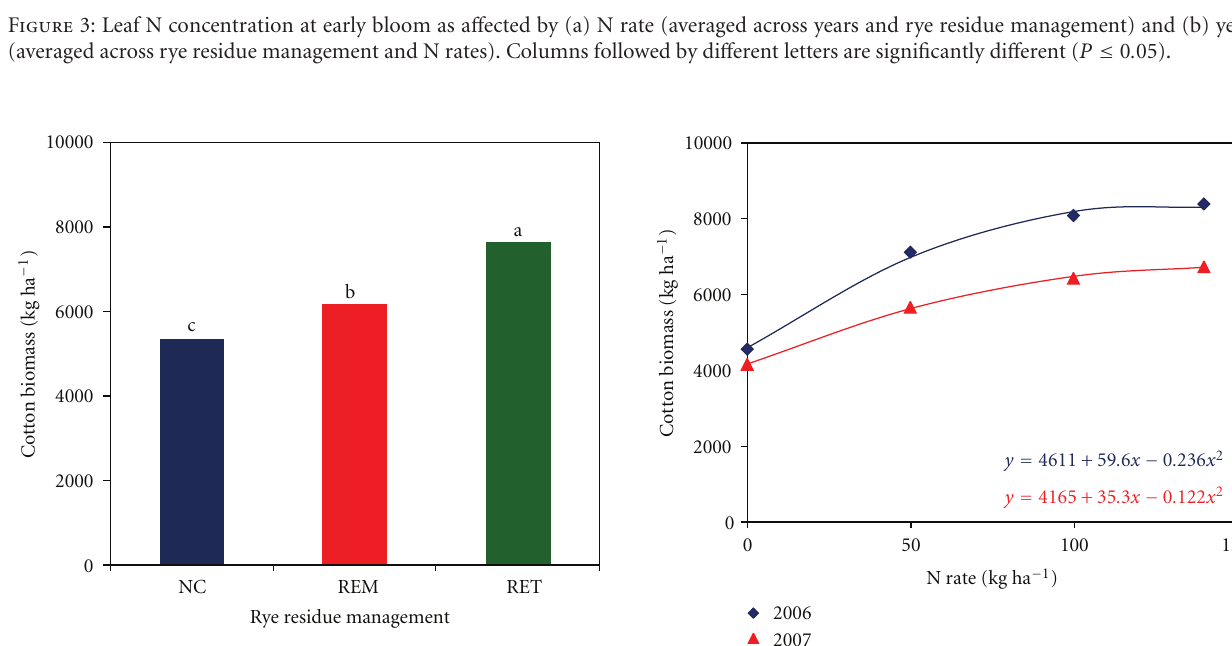
Figure 4: E ff ect of rye residue management on cotton biomass production between first square and cutout, averaged across years and N rates. Columns sharing the same letter are not significantly di ff erent ( P ≤ 0 . 05). NC: no winter cover crop; REM: rye residue removed; RET: rye residue retained.